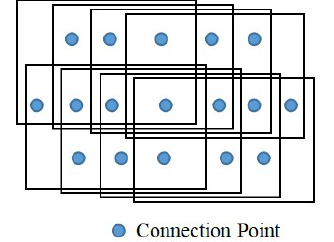
Figure 6. Distribution of connection points